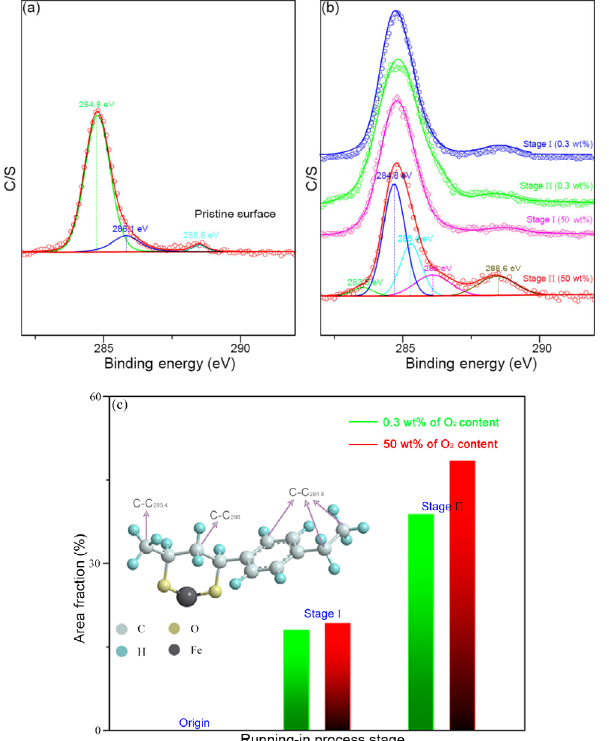
Fig. 6 C 1s XPS spectra measured on (a) a pristine steel surface and inside (b) the worn tracks formed under the different conditions. (c) Area fractions of the C–C bonds (285.4 eV) under different conditions. The upper-left inset in (c) schematically shows the chelated diketone molecule marked with bonding energies for